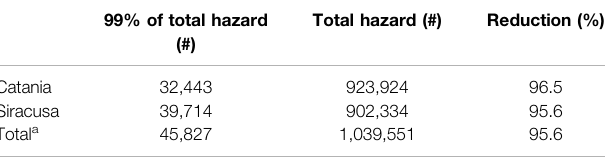
TABLE 1 | Number of scenarios resulting from the disaggregation procedure representing the 99% of the hazard for both Catania and Siracusa in their respective MIH intervals. The number of required simulations with respect to the total number of scenarios representing the hazard in the same interval of MIH is strongly reduced by about 96%.